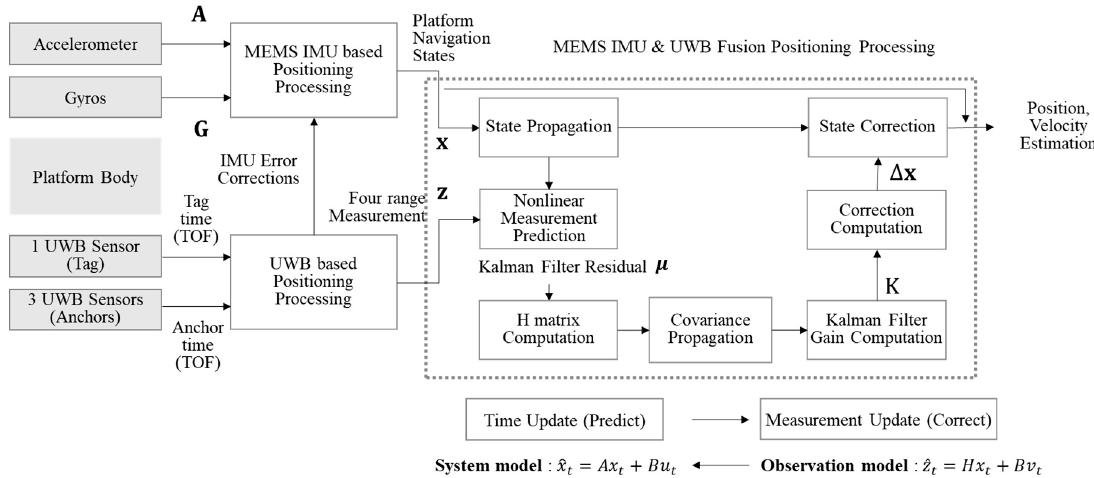
Figure 3. Extended Kalman filtering process for integrated positioning by MEMS IMU and UWB.